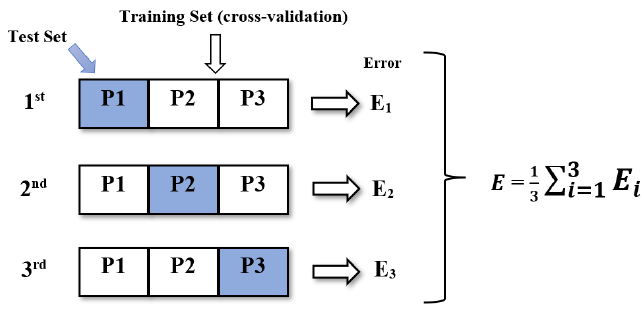
Figure 3. Algorithm for cross-well prediction.